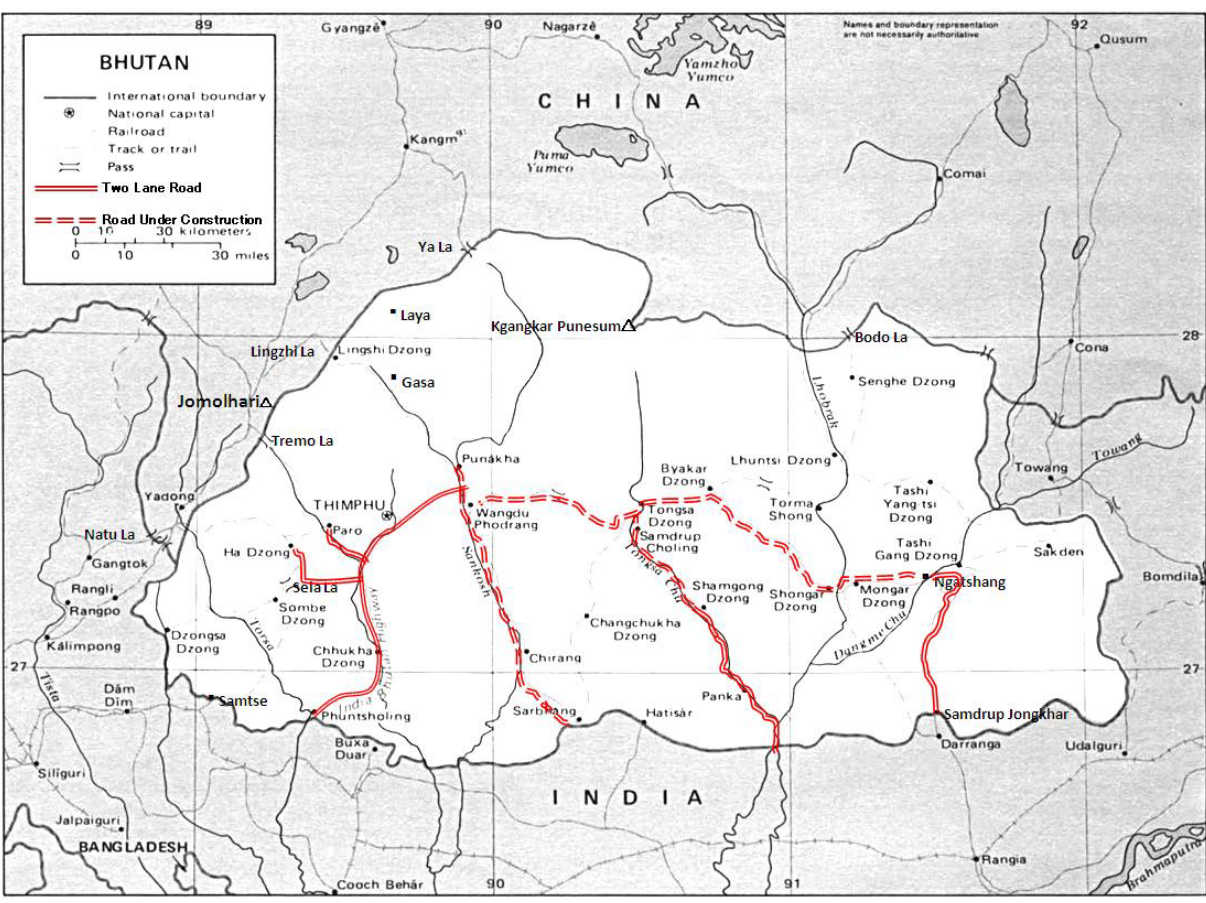
Figure 2. Road condition of Bhutan in 1969